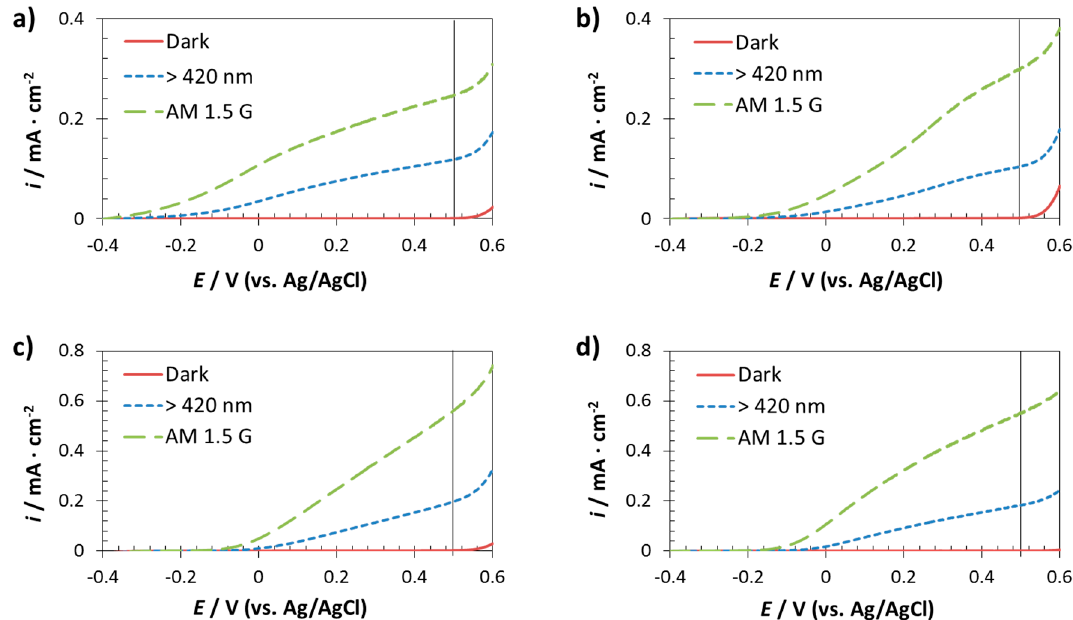
Figure 5. Current/photocurrent density versus applied potential curves of the photoanodes fabricated on FTO substrates: compact layer ( a ) and using different AAO templates: φ 90 nm ( b ), φ 260 nm ( c ) and φ 400 nm ( d ). Dark, visible light ( λ > 420 nm) and solar AM 1.5 G (55 mW·cm − 2 ) illumination conditions were applied.